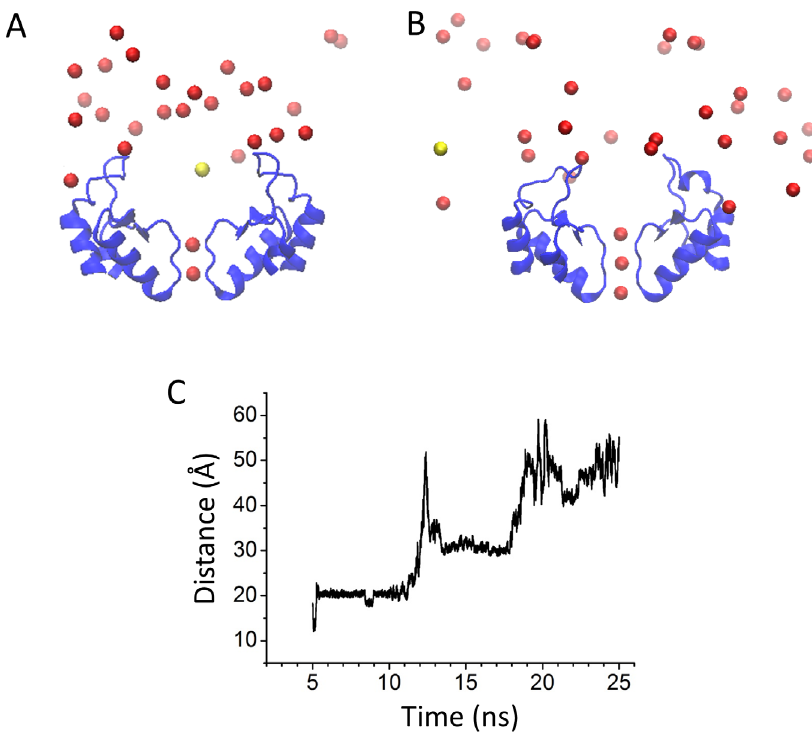
Figure 4. K + ions compete with Mg 2 + to bind at the S0 site. Distributions of extracellular K + and Mg 2 + ions of the initial (A) and final (B) snapshots. Mg 2 + and K + ions are represented by yellow and red spheres, respectively. (C) Evolution of the distance (between the center of the selective filter and Mg 2 + ) against time (5–25 ns). The total simulation time was 25 ns. In the first 5 ns, the ions are fixed for equilibration of the lipids.